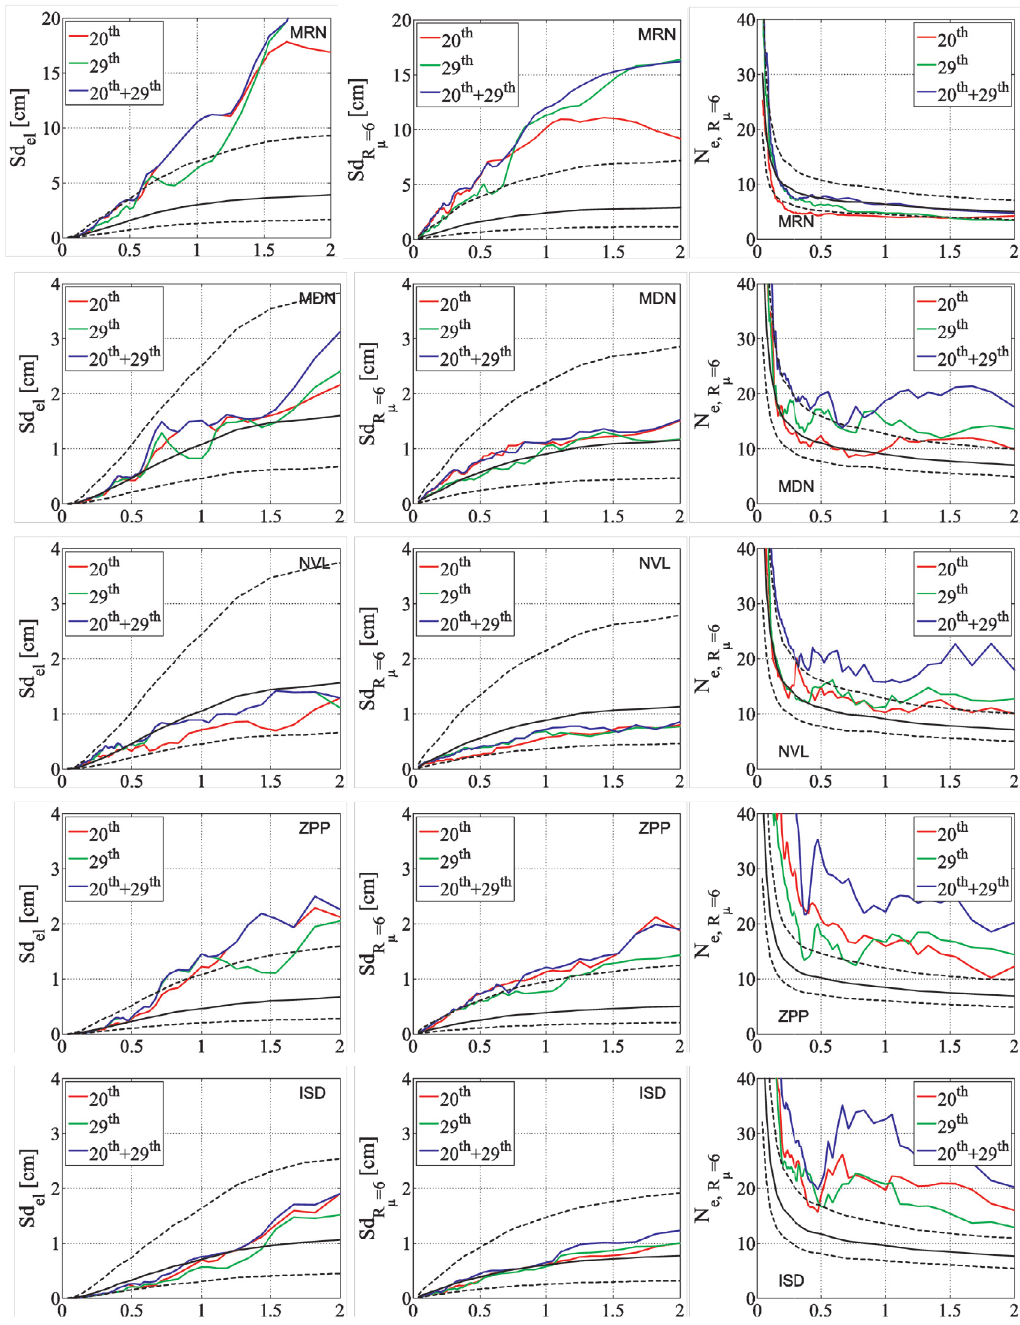
Figure 8. Geometric means of the horizontal elastic and inelastic displacements (first two columns), and equivalent number of cycles spectra (third col- umn) evaluated separately for the two events (May 20 and 29, 2012) and for the sequence (20 th + 29 th ), compared with the GMPEs by De Luca [2011] and De Luca et al. [2012], evaluated for magnitude and distance of the May 20 event. Horizontal axis: always T